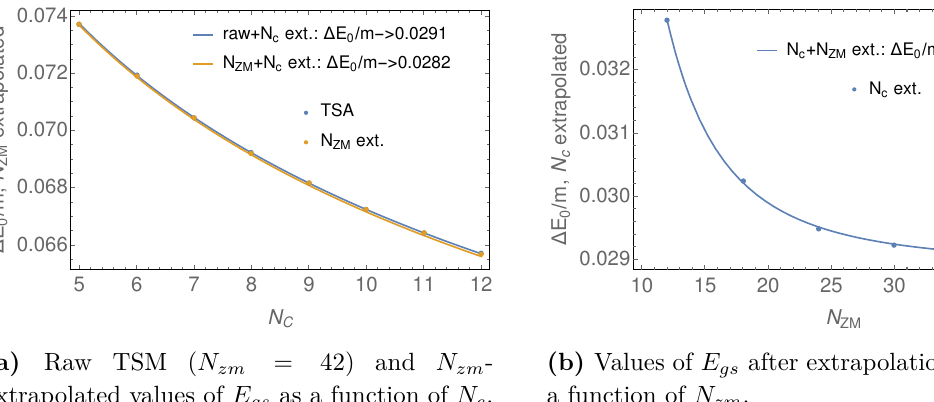
extrapolated values of E gs as a function of N c . a function of N zm . Figure 6. Here we present the two extrapolation schemes for the cutoffs N c and N ZM . We perform the extrapolation for data of the ground state energy at b = 0 . 95 , M ShG R = 1 ). In a) we first extrapolate in N ZM , plotting the results at each N c , then performing a further extrapolation in N c . The results of this extrapolation is shown in the legend. In b) we reverse the order of extrapolations. Note that the data has a much stronger dependence on N c than on N ZM